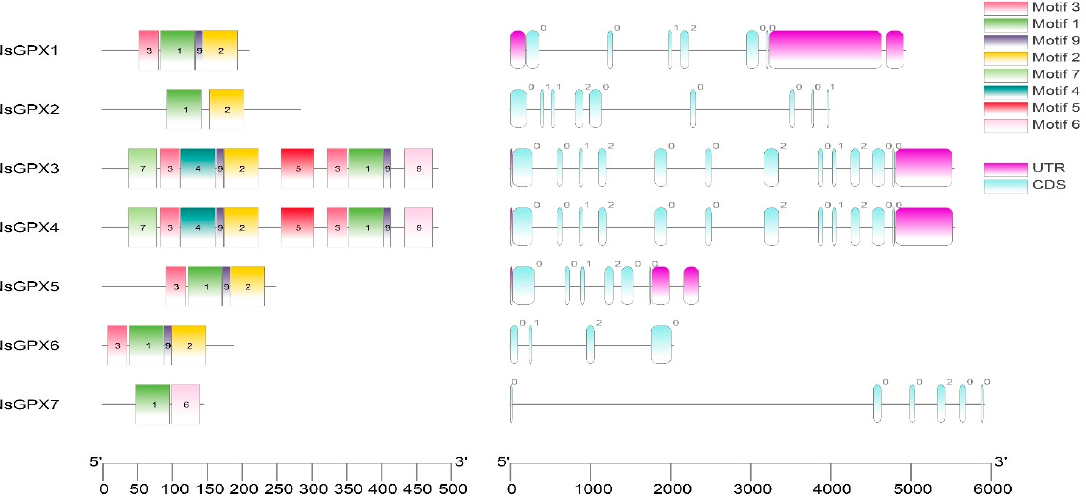
Figure 4. Domain distribution and conservative motif distribution of NsGPX genes. The names of NsGPX s conserved motifs configurations are given. Specific color blocks represent unique motifs. The CDS regions of NsGPX s are indicated by light blue, whilist the NsGPX s UTR regions are represented by purple. The numbers in the right of color blocks are phase number of CDS.